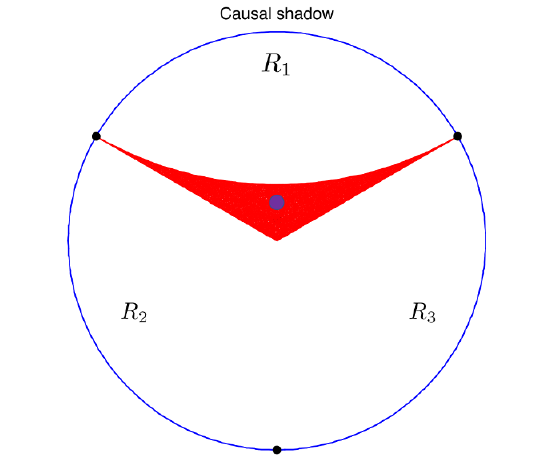
Figure 8 . A schematic plot for causal shadow. This (cid:12)gure is only illustrative and the causal wedges may not be